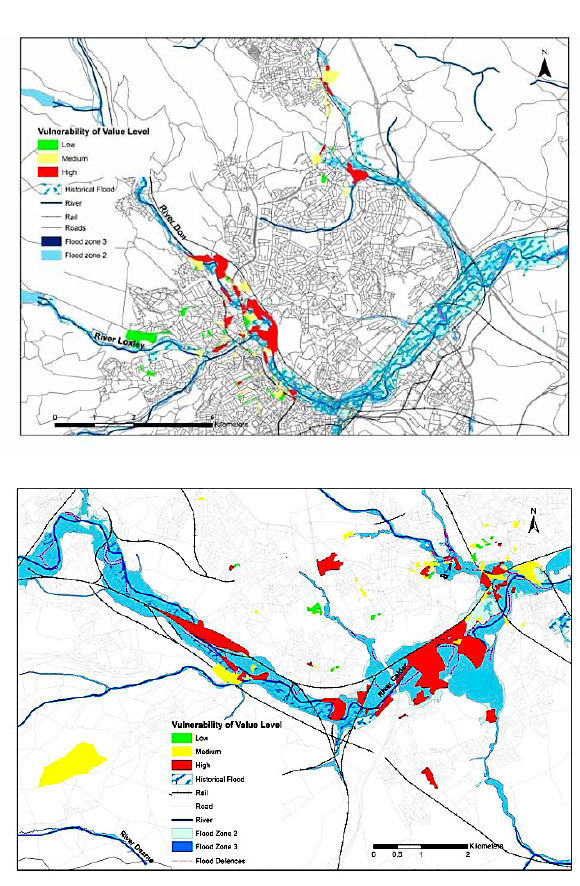
fig. 4. spatial distribution of Vulnerability of value in selected postcodes of Wakefield (top) and Sheffield